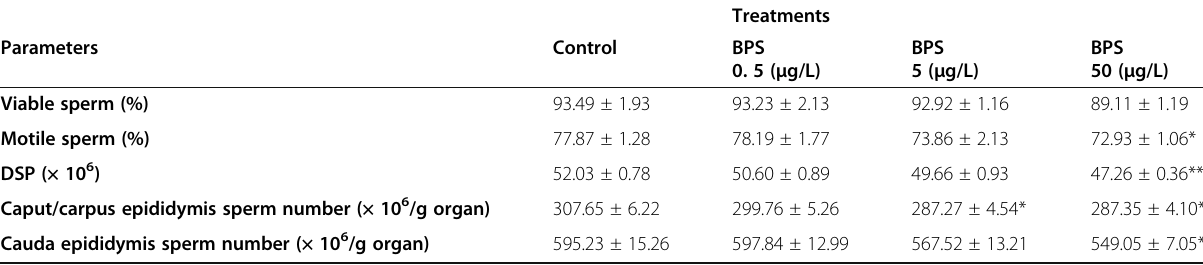
Table 4 Effect of chronic exposure of different concentrations of BPS (0.5 μ g/L, 5 μ g/L, and 50 μ g/L) on sperm parameters and sperm number in epididymis of rats